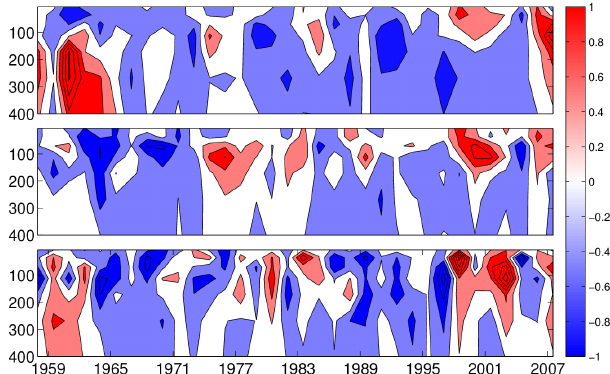
Figure 3 Temperature anomalies (contour interval: 0.2, units: K; seasonal cycle 335 Fig. 3. Temperature anomalies (contour interval: 0.2, units: K; sea- removed) of Box 1 (top), Box 2 (middle), and Box 3 (bottom). 336 sonal cycle removed) of Box 1 (top), Box 2 (middle), and Box 3 337 338